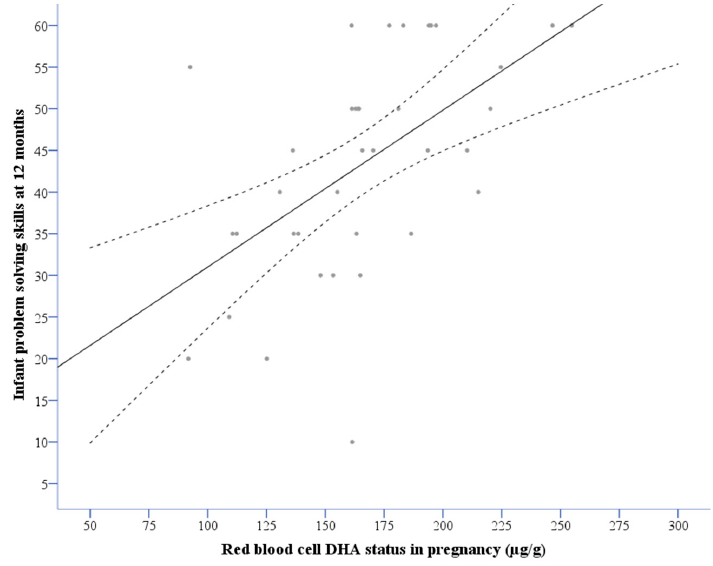
Figure 2. The correlation with 95% confidence interval between maternal red blood cell DHA status in pregnancy and infant problem-solving skills at 12 months. DHA: docosahexaenoic acid. Table 3. Association between DHA status in pregnancy, mothers’ educational level, and infant problem solving at 12